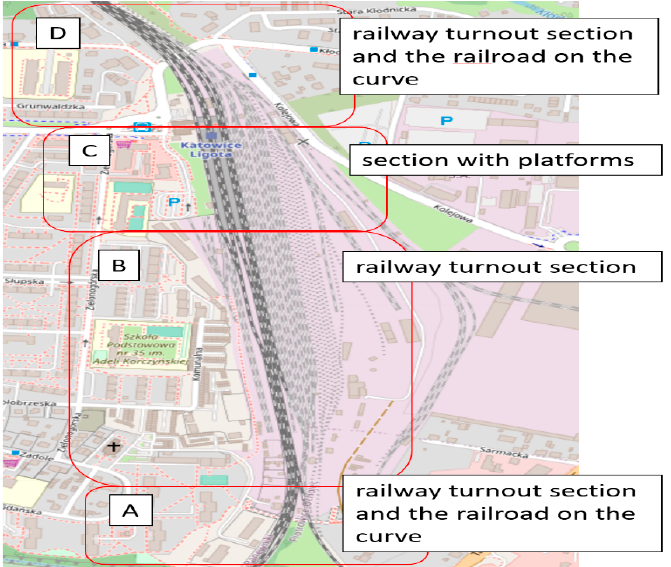
Figure 13. Site plan of testing workshop with defined segments, A, B, C, and D are selected groups of railway infrastructure of the testing workshop.